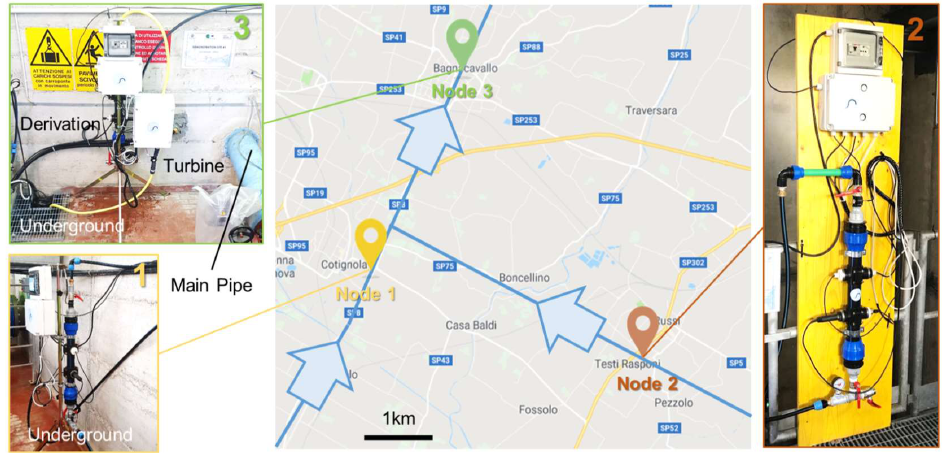
Figure 8. Map of the installation sites of the three nodes during the field validation in a water distribution network in Romagna, Italy. They are located in Y-junction.